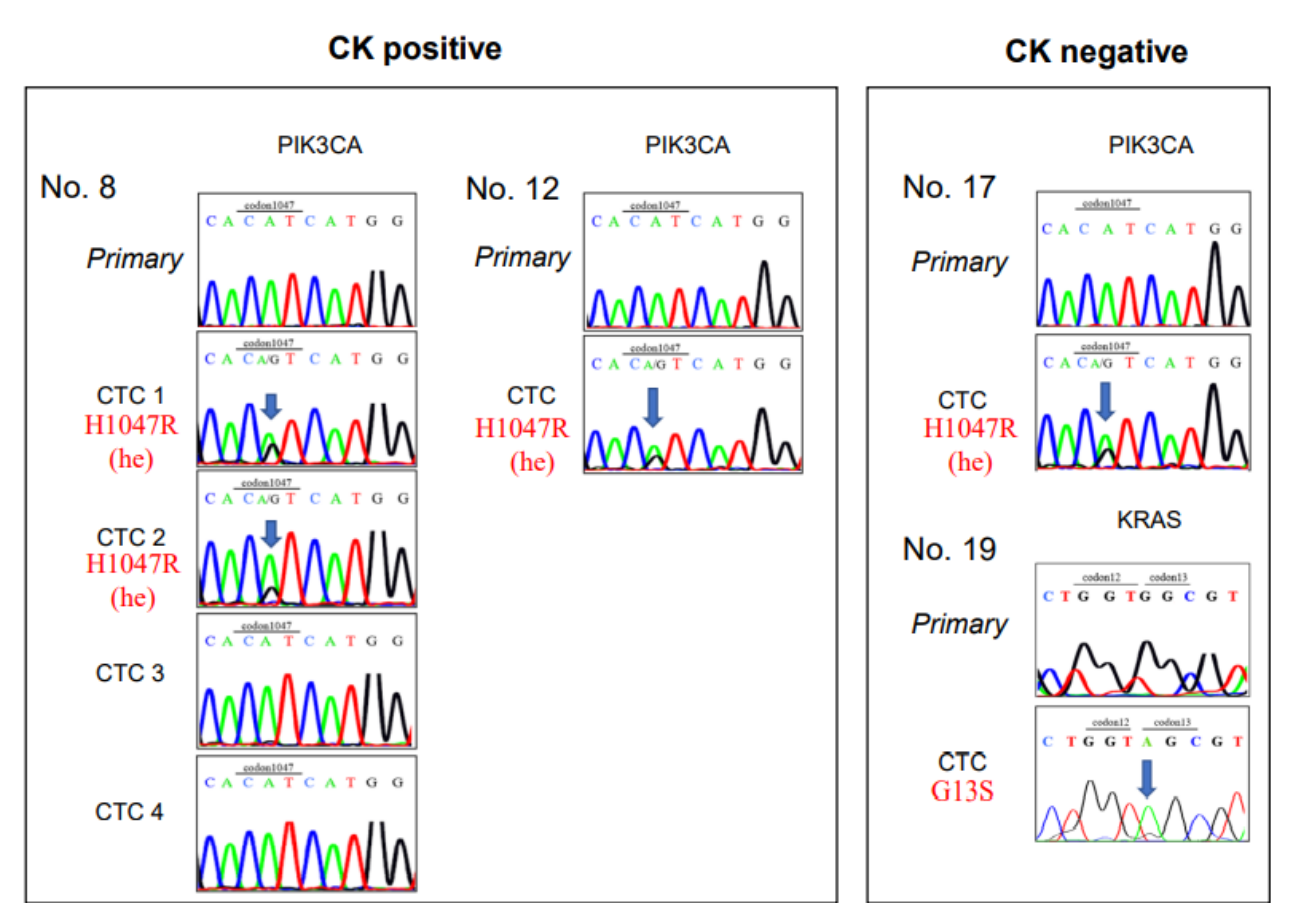
Figure 3. Sanger sequencing of CK-positive CTCs and CK-negative CTCs. Sanger sequences show gene mutations in clinical samples from patients with colorectal cancer. ( Left ) Sequences are shown for five CK-positive CTCs, including 4 CTCs from Patient number 8 (Pt. No. 8) and one CTC from Pt. No. 12. ( Right ) Sequences are shown for two CK-negative CTCs, including one each from Pt. Nos. 17 and 19. Primary: cell from the primary tumor; CK: cytokeratin; CTC: circulating tumor cell.